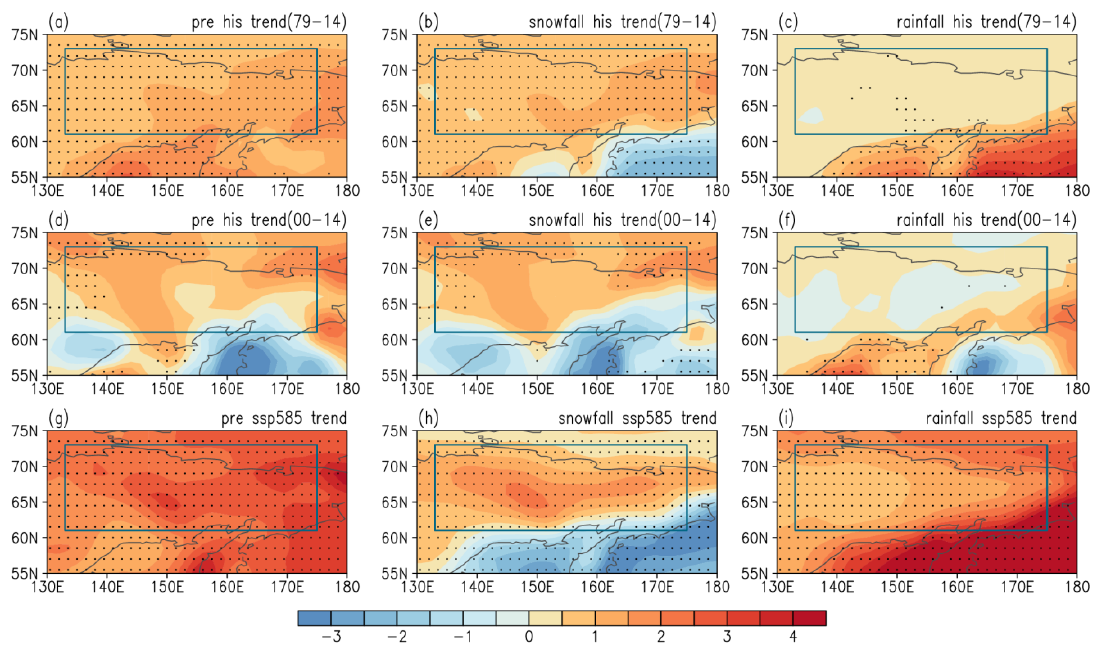
Figure 8. Linear trends of NDJF ( a , d , g ) precipitation (pre, mm month − 1 10a − 1 ), ( b , e , h ) snowfall (mm month − 1 10a − 1 ), and ( c , f , i ) rainfall (mm month − 1 10a − 1 ) of ( a – c ) historical forcing for the period 1979–2014, ( d – f ) historical forcing for the period 2000–2014, and ( g – i ) projections under SSP585 scenarios for the period 2015–2100. Dotted regions denote trends significant at the 95% confidence level.